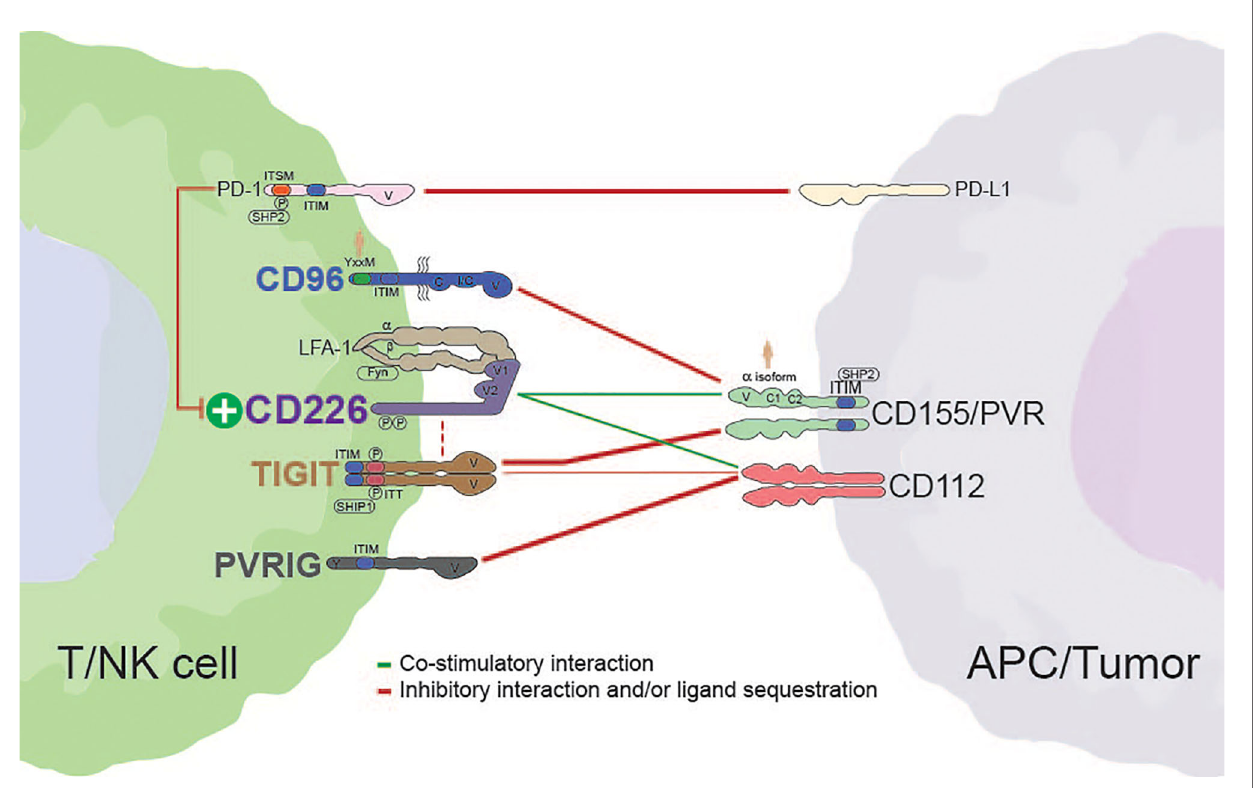
FIGURE 1 | Interactions between members of the CD226 axis. Dashed red lines indicate the potential for cis interactions/inhibition. The weight of each line is representative of the relative strength of interaction. Alternative interactions not shown (e.g., CD96 with CD111; TIGIT with CD113 or PVRL4). Human silhouettes signify that a motif or isoform is not present in rodents. APC, antigen presenting cell; V, variable-like domain; C, constant-like domain; I/C, I/C-like folding pattern present in isoform 2 of human CD96; P, tyrosine phosphorylation site; SHP2, Src homology 2-containing phosphotyrosine phosphatase; ITIM, immunoreceptor tyrosine-based inhibition motif; SHIP1, Src homology